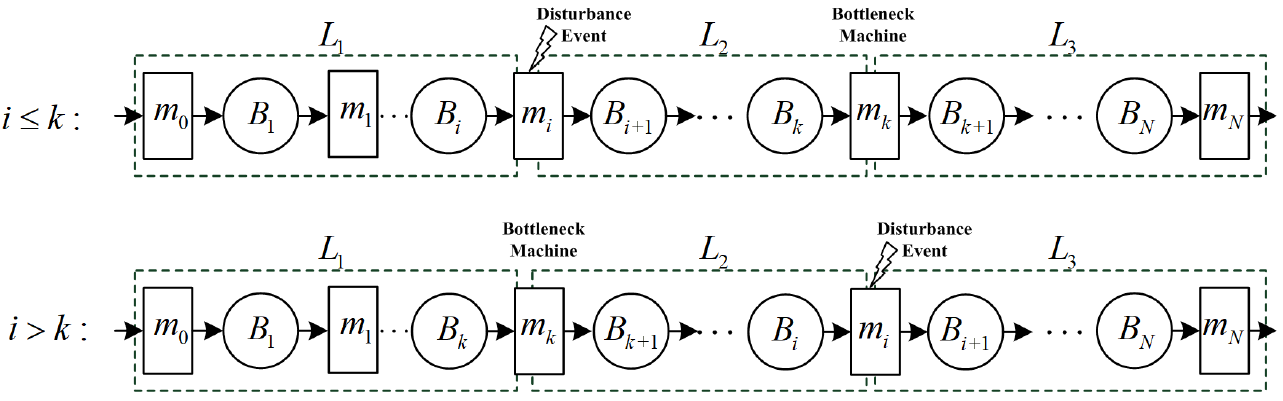
Figure 6. Line division according to the location of m i and m k .